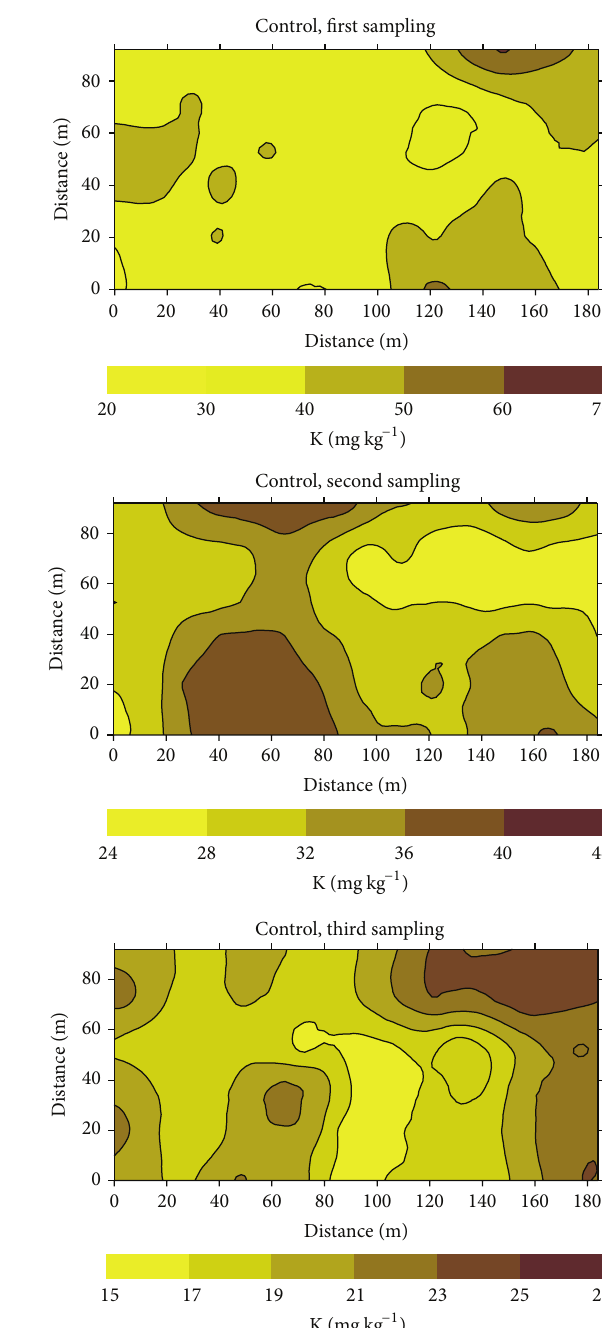
Figure 6: Kriging maps for Mehlich-1 extractable potassium (K) at the control treatment, for successive sampling